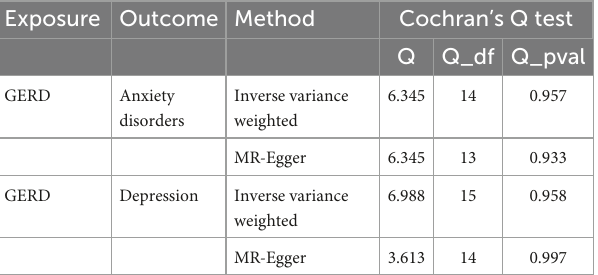
analysis are presented in Supplementary Table 2 . In addition, the F -statistics of all IVs ranged from 29.75 to 50.68.